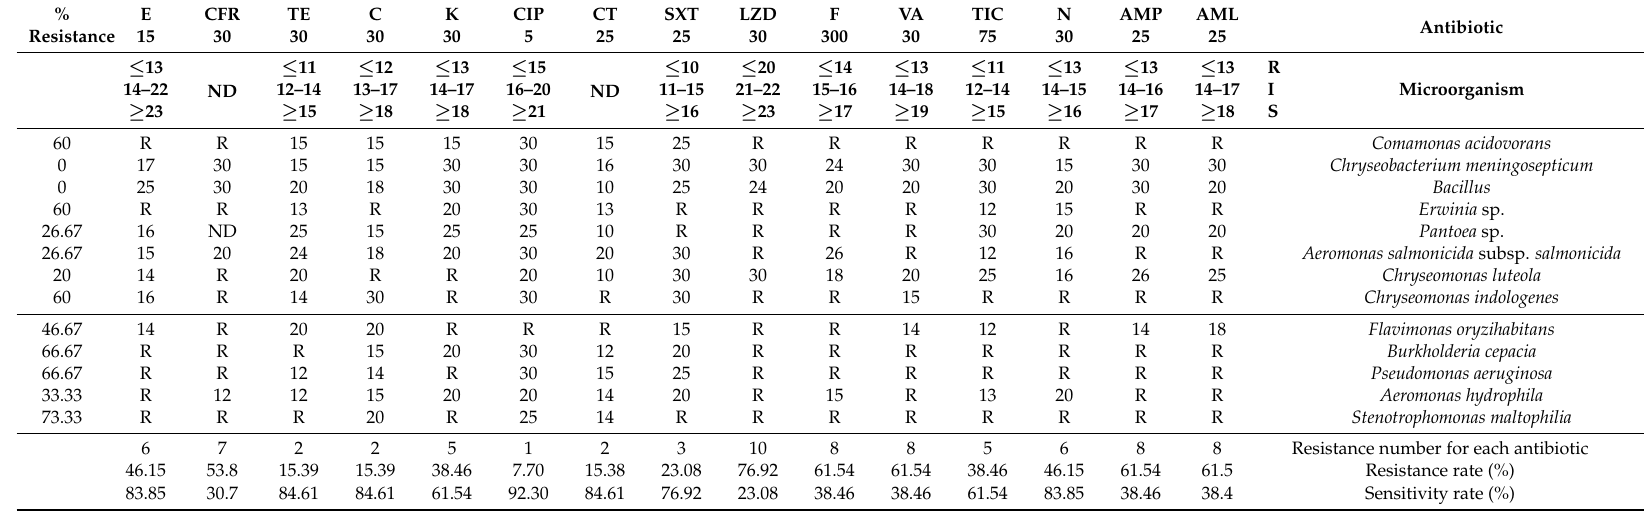
Table 4. Antimicrobial resistance of 24 h cultured bacterial isolates based on the development of inhibitory zone diameters after application of discs containing specific antimicrobial